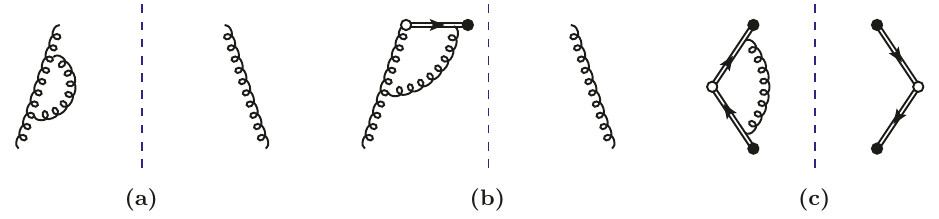
(1) jj ′ ,ii (1) (c). gg (a and b) and M S,g M